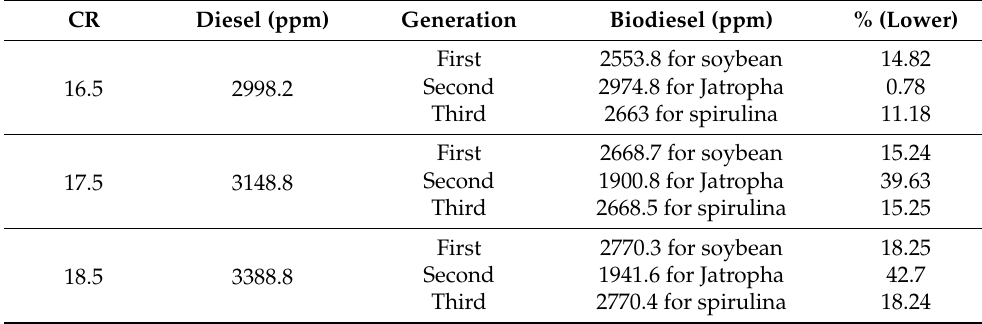
Table 8. Comparison of NO x emissions at full load and different CRs [242].